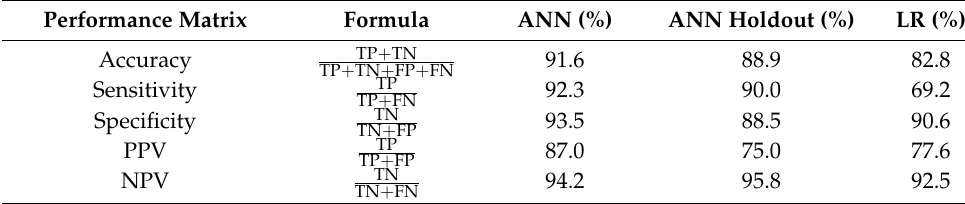
Table 4. Model evaluation and performance matrices.